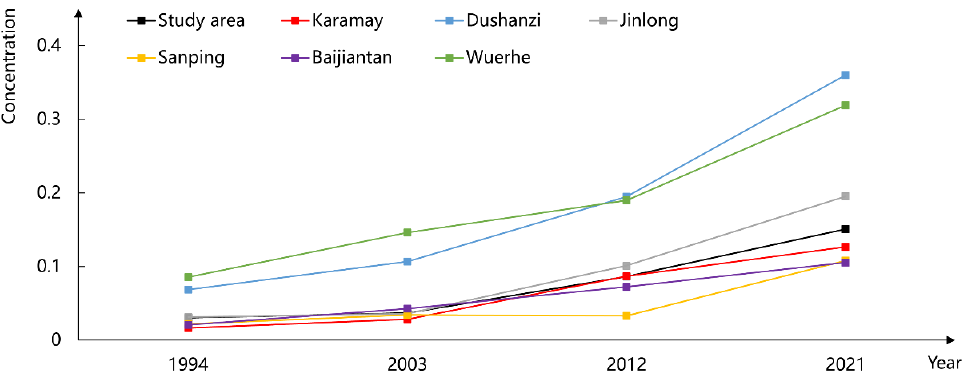
Figure 6. Changes in the urban concentration of each township from 1994 to 2021.